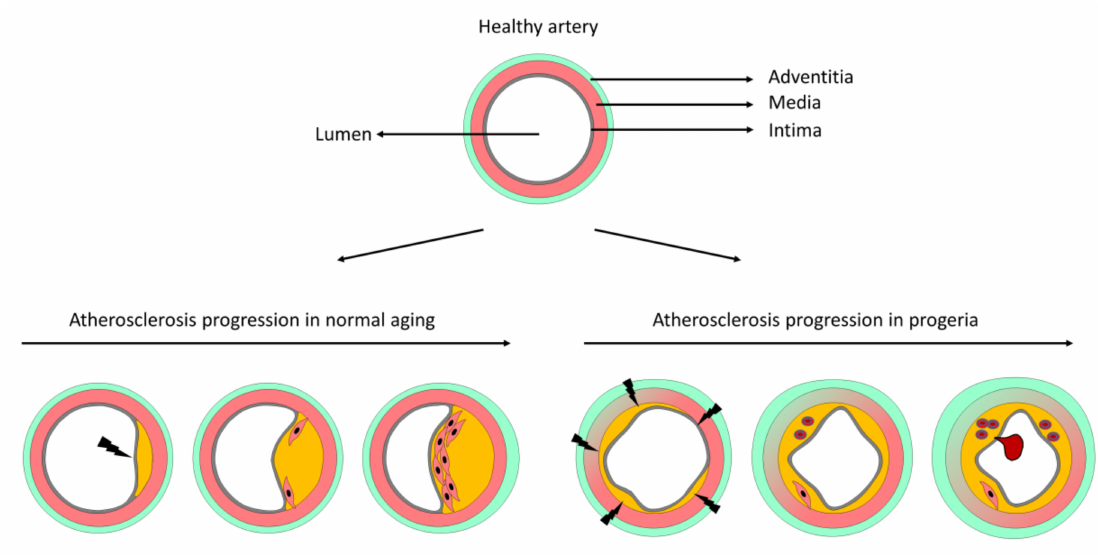
Figure 6. Proposed model of atherosclerosis progression in normal versus progerin-induced mouse aging. A healthy artery is composed of three layers, the intima (containing the endothelial cell monolayer and an internal elastic lamina), the media (mainly composed of several layers of smooth muscle cells and elastic fibers), and the adventitia (containing mostly immune cells and fibroblasts). During normal aging, atheroma plaques form predominantly at arterial sites susceptible to atherogenesis due to disturbed blood flow and typically grow eccentrically. As the lesion grows, smooth muscle cells from the media migrate into the intima, proliferate, and produce collagen to form a fibrous cap that protects the plaque from disruption. During progerin-induced aging, smooth muscle cells in the arterial media die, triggering plaque formation over almost the entire intimal surface. These lesions typically contain few smooth muscle cells and display signs of instability, including the presence of erythrocytes and a thin or absent fibrous cap. Vulnerable plaques in HGPS are prone to disruption, thus facilitating thrombus formation and myocardial infarction or stroke. Atherosclerosis in progeric mice is also accompanied by extracellular matrix accumulation in the media, elastin structure alterations, and prominent adventitial thickening.